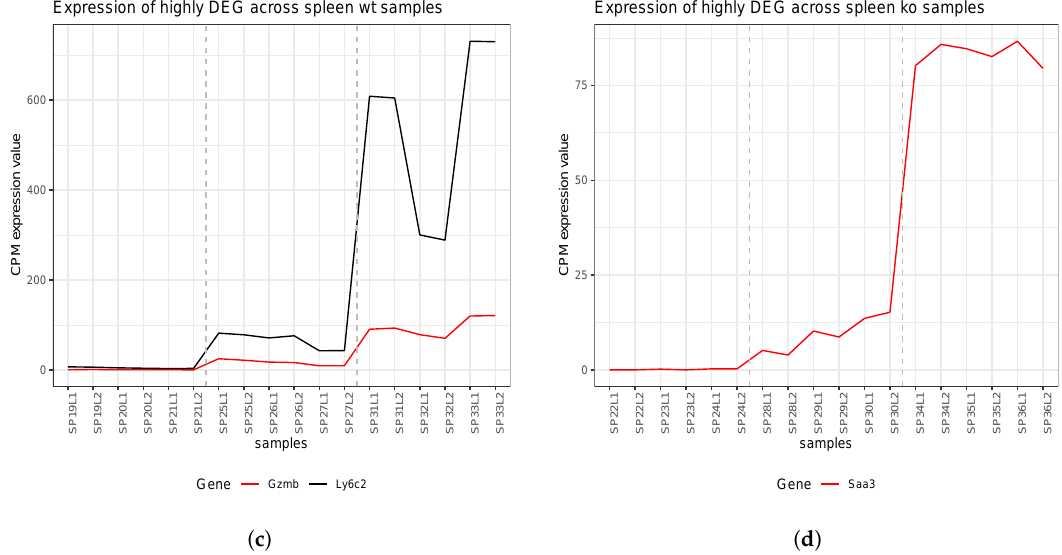
Figure A9. CPM-normalized expression values of highly DEG identified across ( a ) liver wt samples, ( b ) liver ko samples, ( c ) spleen wt samples and ( d ) spleen ko samples. Dashed lines separate samples from the three groups under study: controls, cases at 3 d p.i. and cases at 5 d p.i. Note sample order within same group is